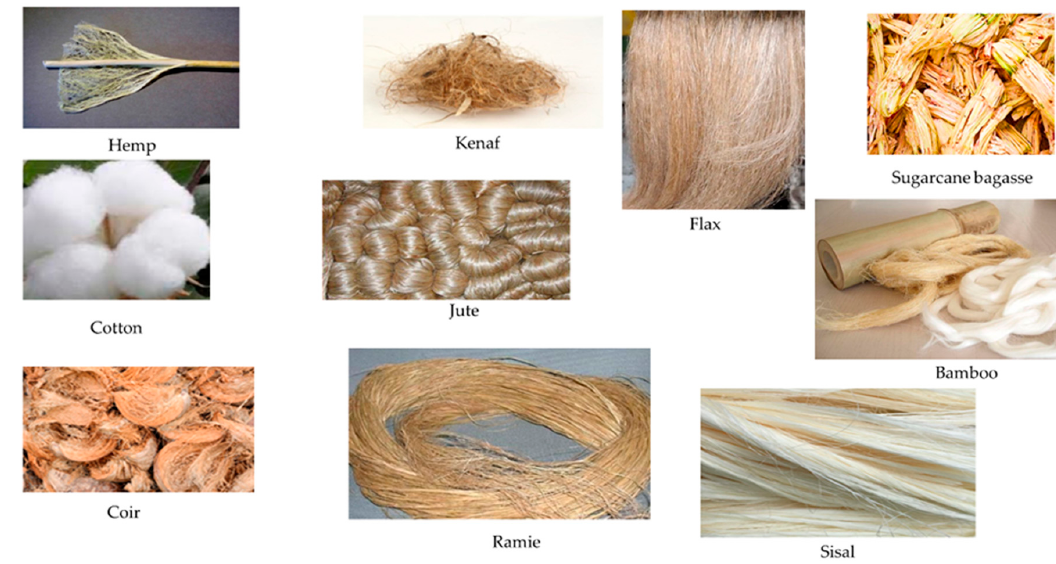
Figure 5. Images of natural biofibers [34,59–68].